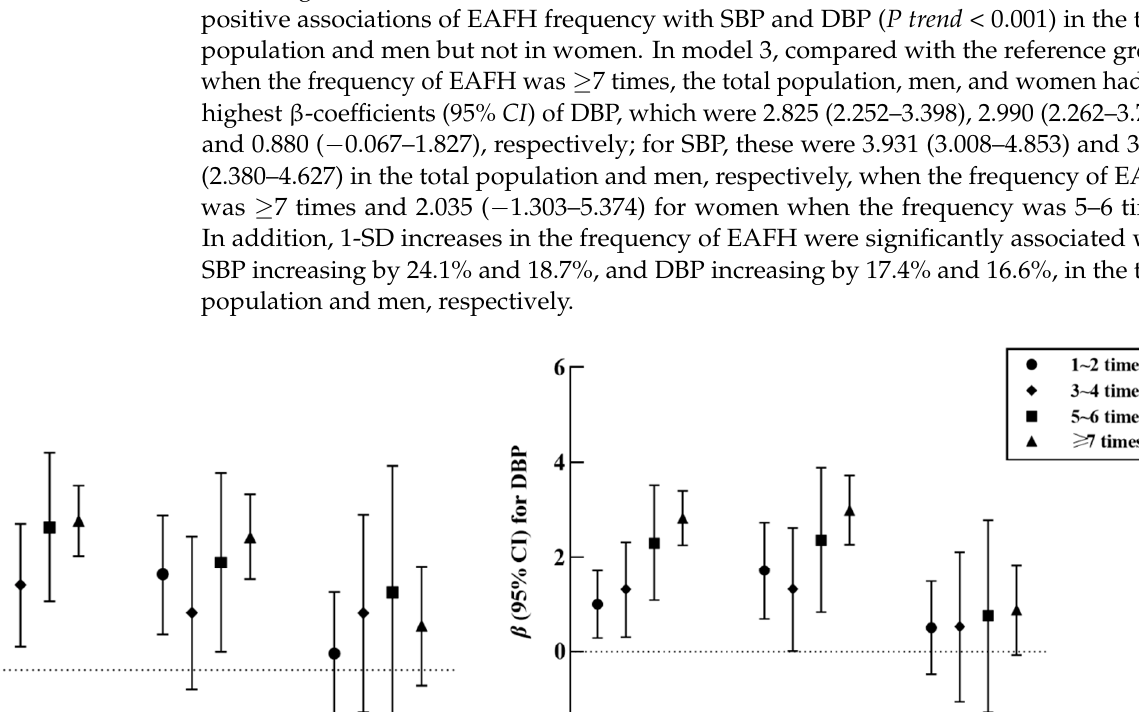
Figure 2. ORs and 95 % CIs of weekly frequency of EAFH for hypertension from restricted cubic splines. OR , odds ratio; CI , confidence interval; EAFH, eating away from home. The fully adjusted model included age, gender (only for total participants), marital status, education level, average income per month, smoking status, alcohol consumption, physical activity, abundant vegetable and fruit intake, high-fat diet, and family history of hypertension.